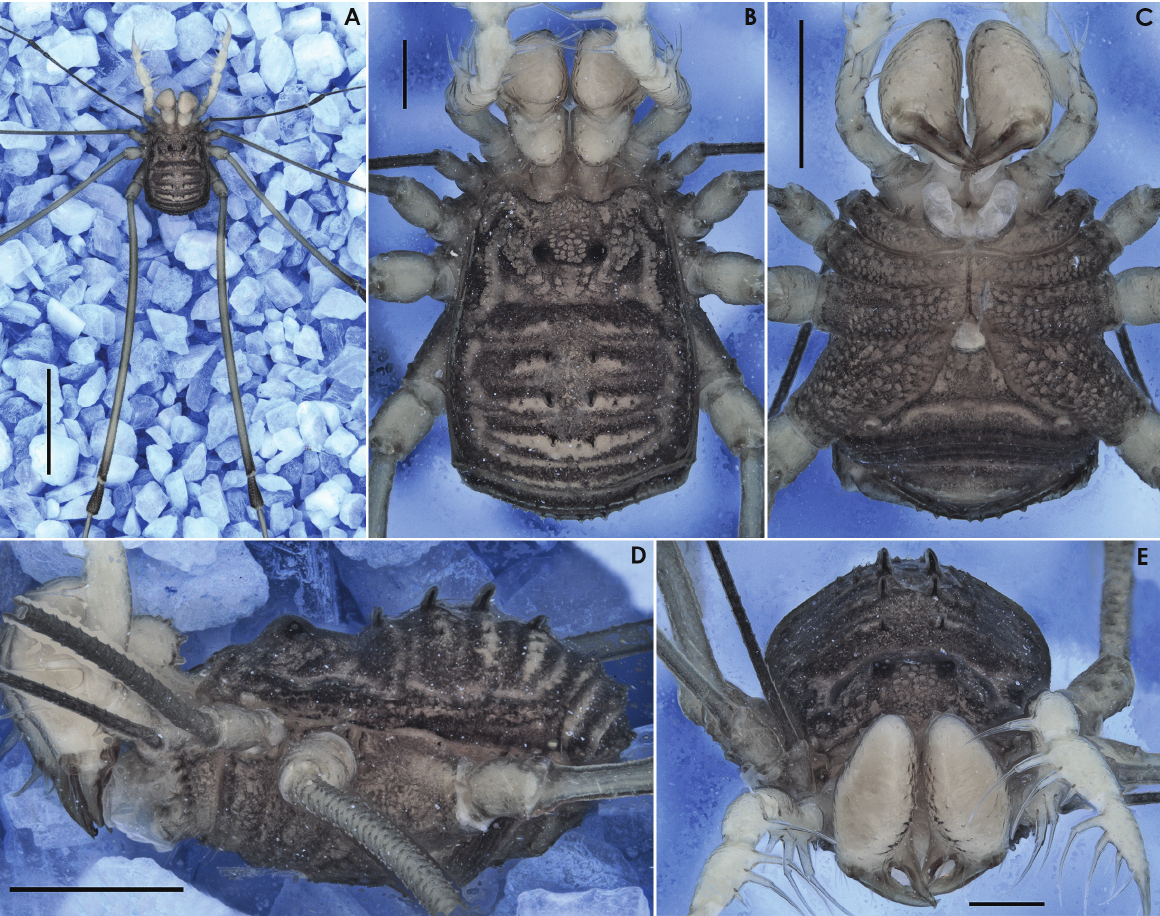
Figure 1. Photographs of Barinas guanenta sp. nov. (ICN-Ao-742.1), male holotype. Habitus in panoramic ( A ), dorsal ( B ), ventral ( C ), lateral ( D ), and frontal ( E ) views. Scale bars: 3 mm ( A ); 1 mm ( C, D ); 0.5 mm ( B, E